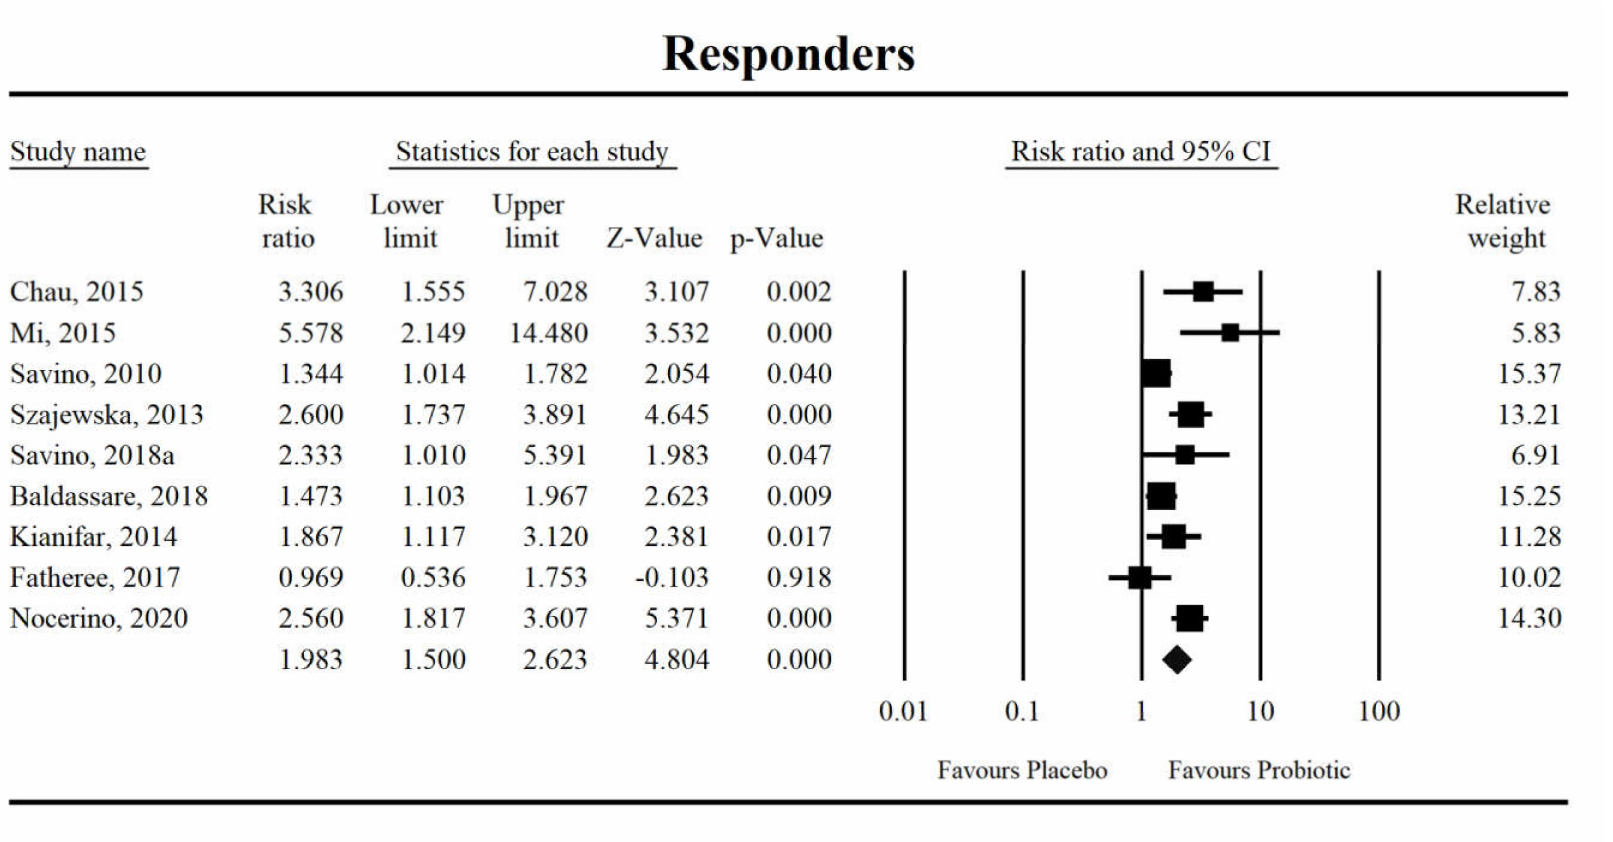
Figure 3. An e ff ect size (random model), risk ratio, for the overall e ff ects of probiotics with regard to a 50% reduction in crying duration. Q = 25.7, df (Q) = 8, p = 0.001, I-squared =